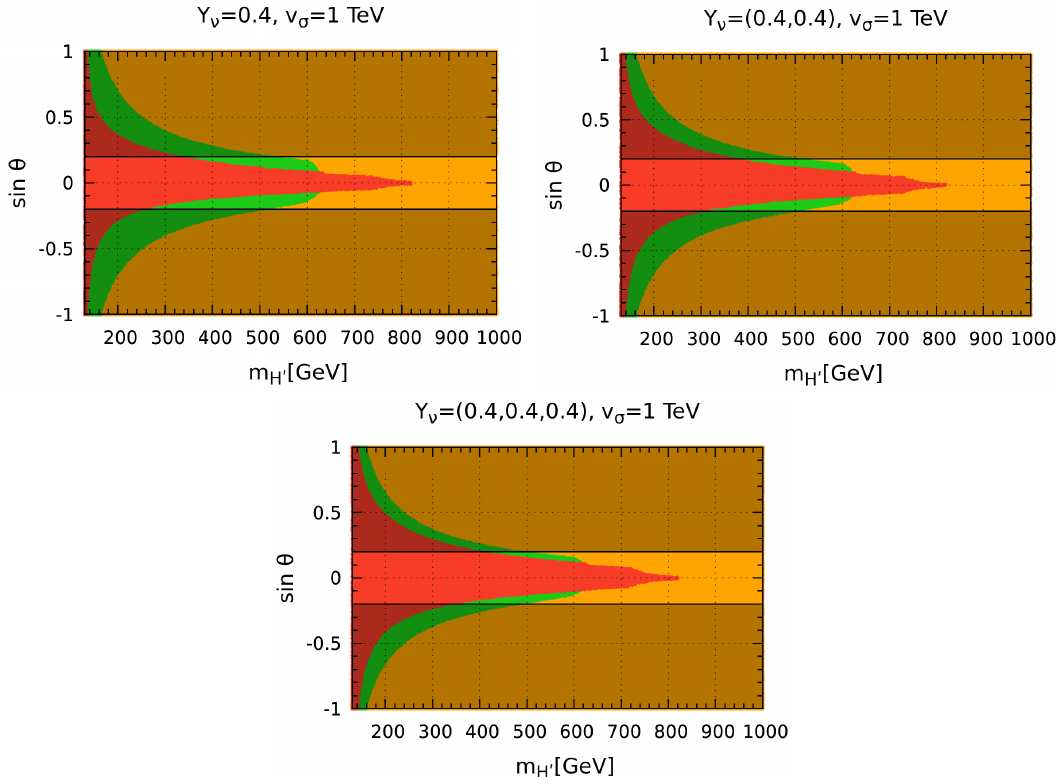
Figure 18 . The left figure of upper panel is for the reference (3,1,1) majoron inverse seesaw with Y ν = 0 . 4 . The right upper panel is for (3,2,2) case with Y ν = Diag (0 . 4 , 0 . 4) . The lower panel is for (3,3,3) case with Y = Diag (0 . 4 , 0 . 4 , 0 . 4) . We have fixed v = 1 TeV, the neutrino mass scale ν σ Λ = 10 TeV and have imposed the stability-perturbativity constraints up to Planck scale. The color code is same as in figure